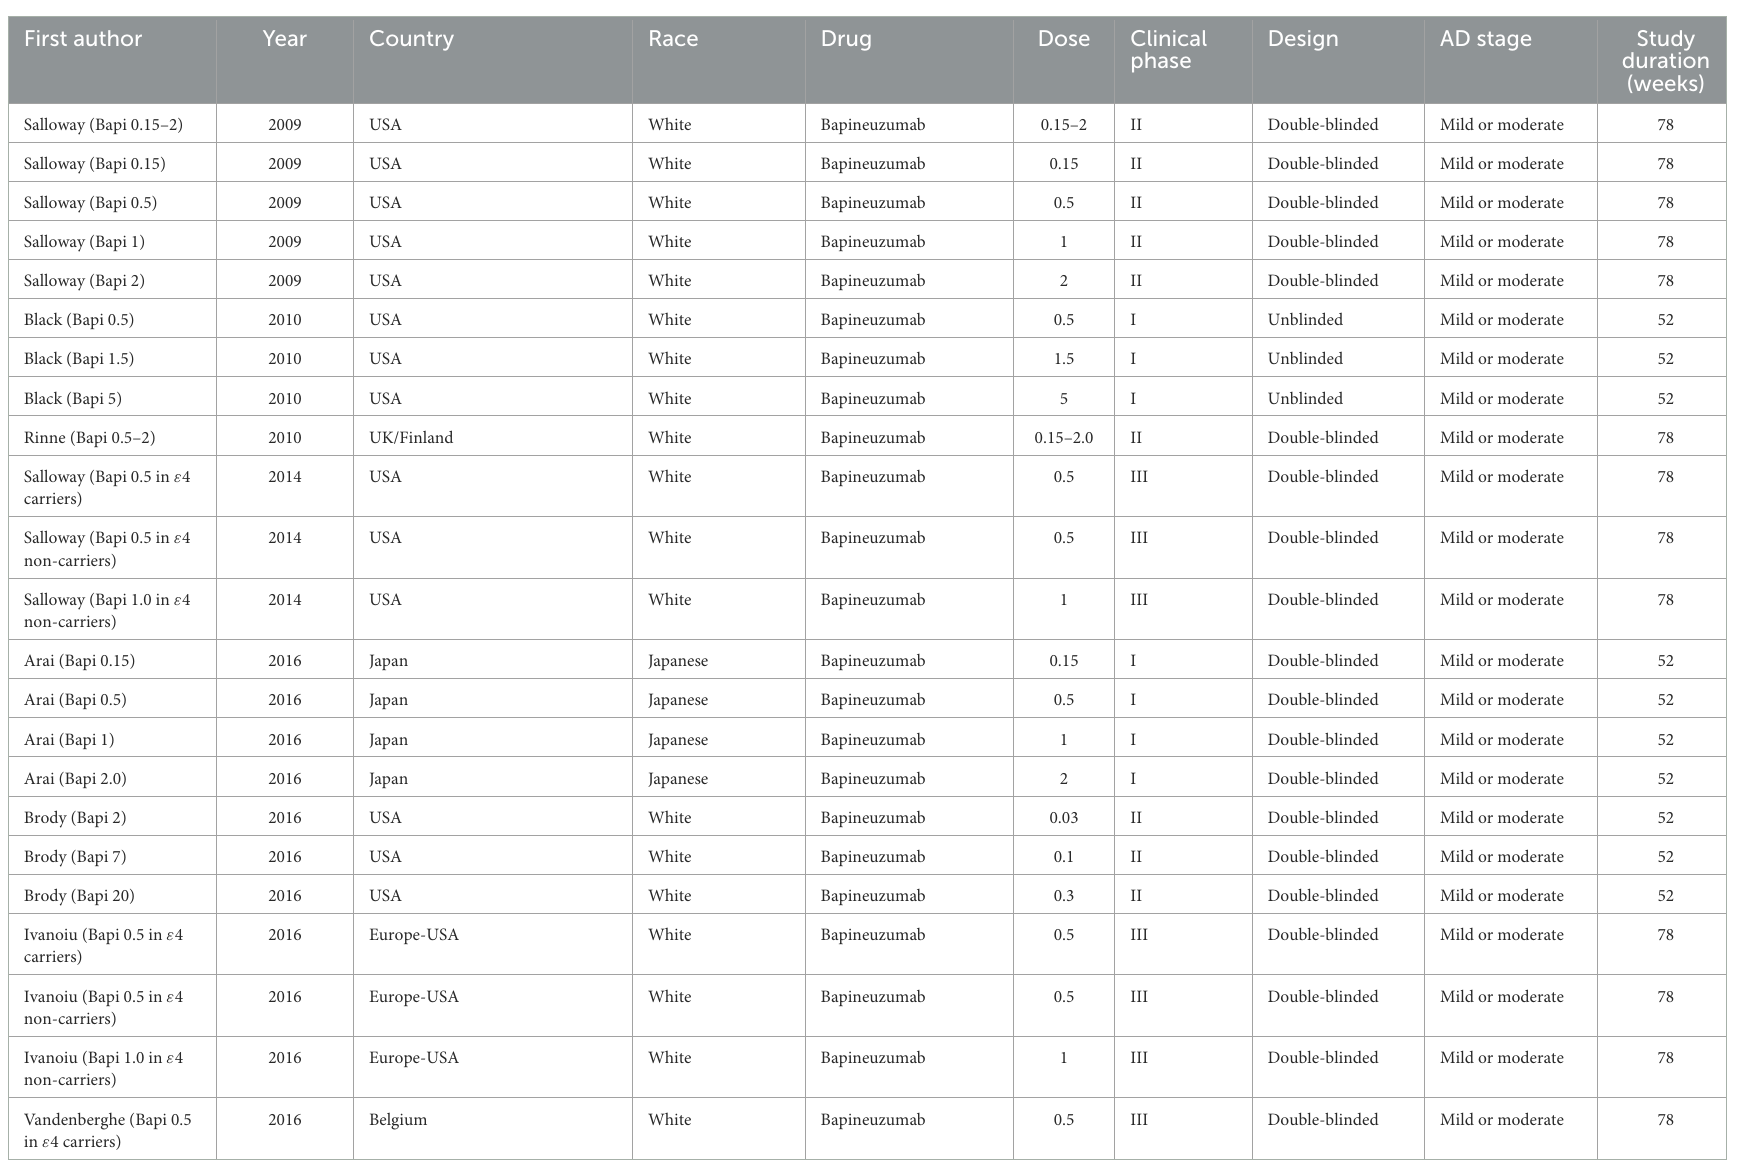
TABLE 1 Characteristics of eligible trials evaluated in this